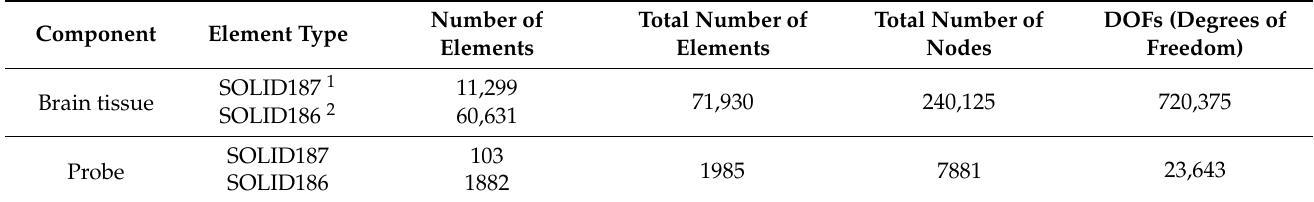
Figure 3. Schematics of the implantation and implanted model. ( A ) A 3D finite element (FE) model including mesh configuration. ( B ) An illustration of the implanted mouse brain. The target region (hippocampal region: mediolateral (ML): − 3, anteroposterior (AP): − 2.8, dorsoventral (DV): 3 (mm)) is marked as the red point in the above figure. Table 1. The detailed specification of the finite element